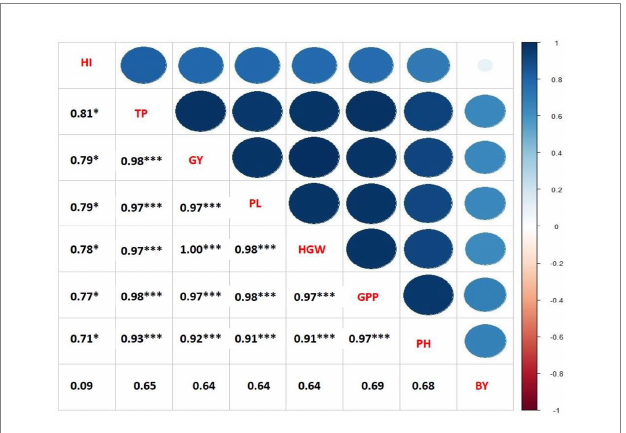
FIGURE 1 Correlation coefficients of seed yield per plant with other yield contributing characteristics of mungbean under different concentrations and frequencies of GA 3 (PH, plant height; TP. total pods plant − 1 ; PL. pod length; GPP, grains pod − 1 ; HGW, hundred grains weight; GY, grain